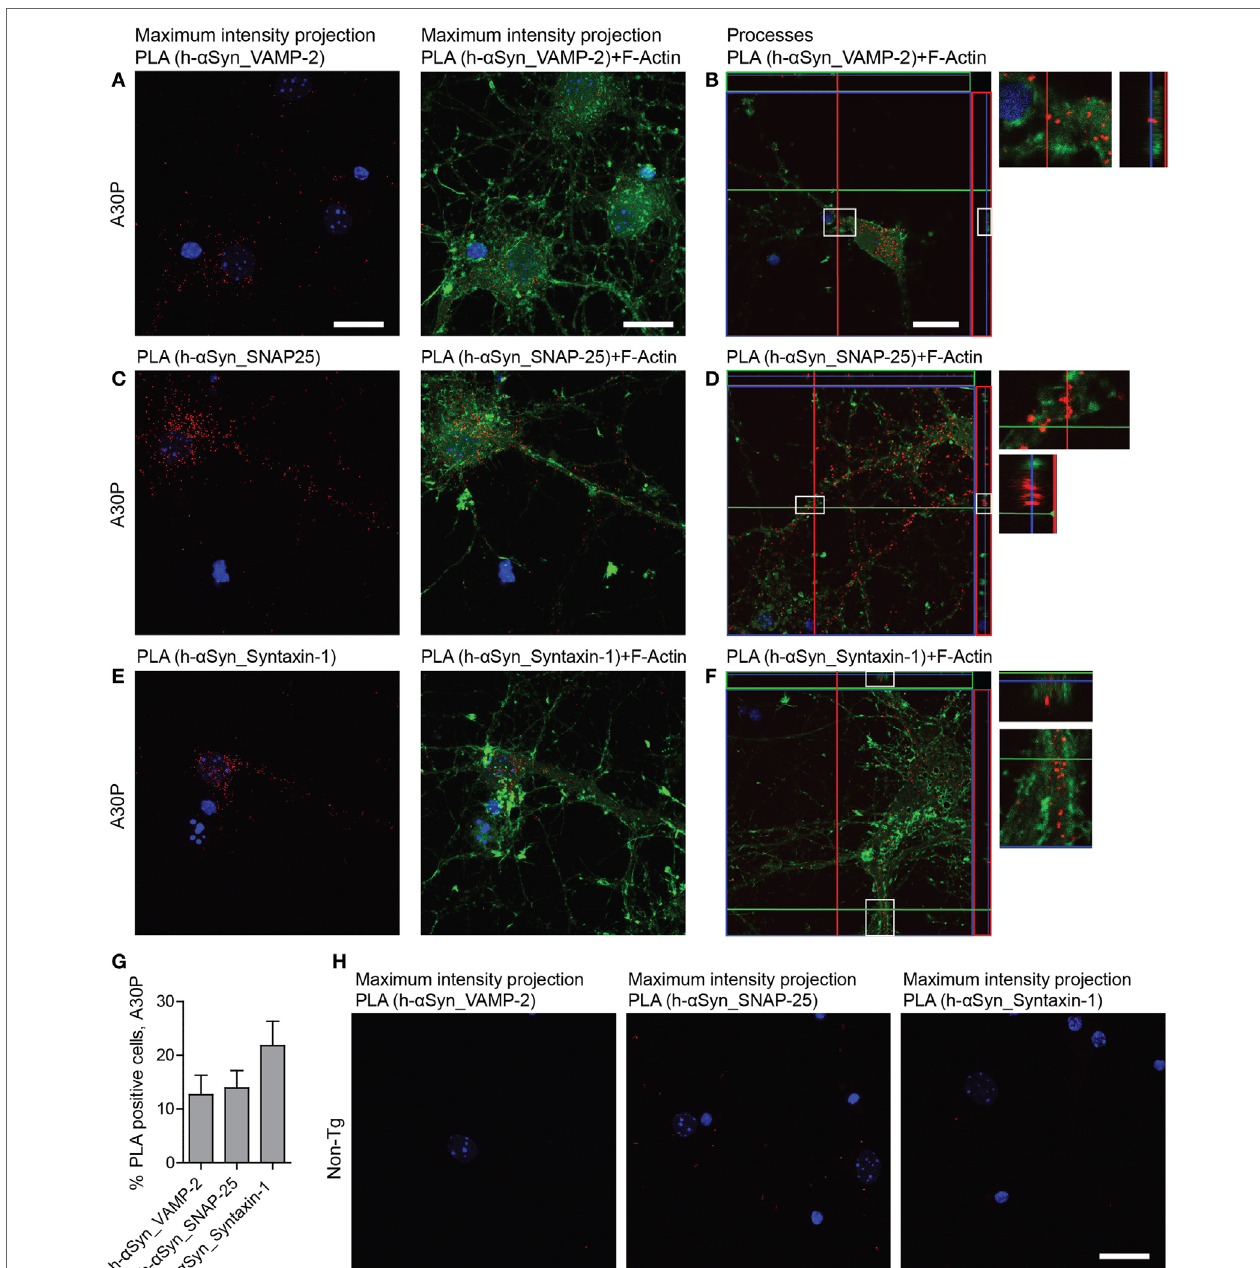
FigUre 6 | Representative confocal images of in situ proximity ligation assay (PLA) (red) between h-alpha-synuclein ( α Syn) (Syn 204) and VAMP-2 (a,B) , h- α Syn (Syn 204) and SNAP-25 (c,D) , and h- α Syn (Syn 204) and syntaxin-1 (e,F) in tg A30P neurons and in non-tg neurons (h) . Maximum intensity projections of a confocal z-stack including a whole cell were performed to observe the maximum amount of PLA puncta (a,c,e) . Cross section of the processes allows visualization of the PLA puncta in an orthogonal view [ (B,D,F) , inlet], scale bar 20 µm. F-actin stained by phalloidin-FITC (green) and DAPI (blue). Quantification of PLA between h- α Syn and VAMP-2, h- α Syn and SNAP-25, and h- α Syn and syntaxin-1 in A30P neurons (g)